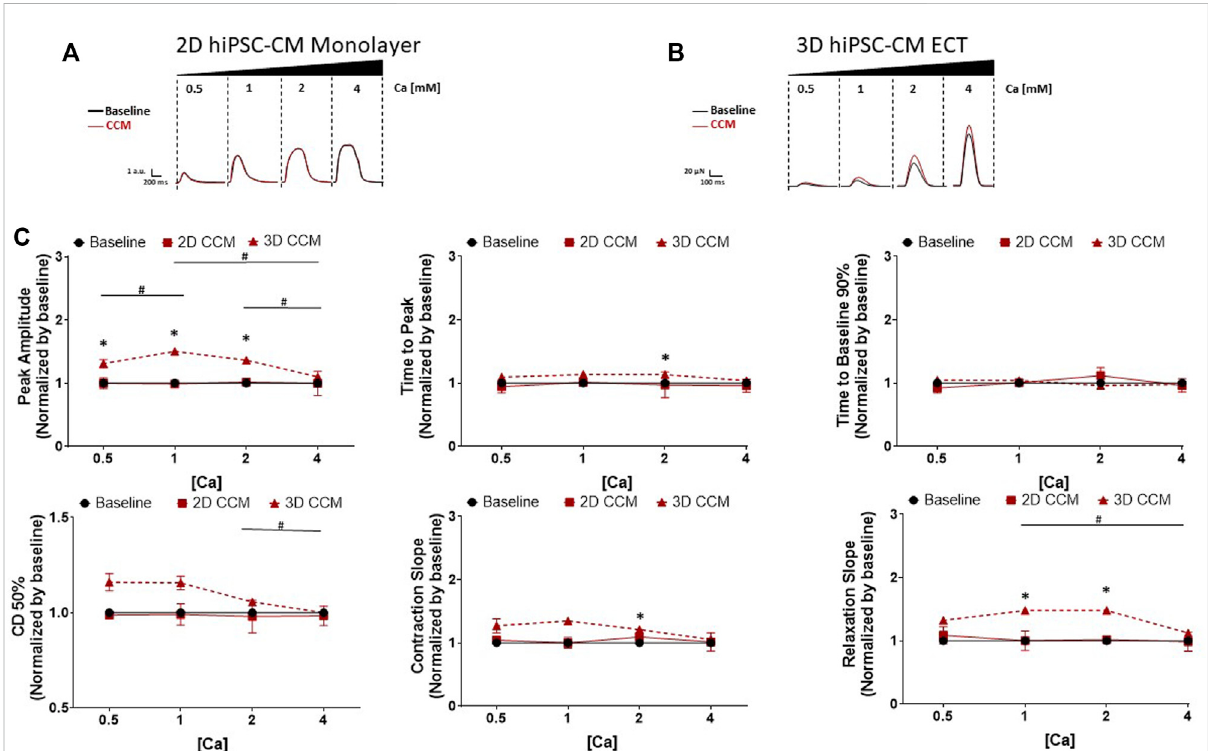
FIGURE 3 Effect of Extracellular Ca Modulation on CCM Response in 2D and 3D models (A) Representative contraction traces for baseline (i.e., fi eld stimulation pacing, 1 Hz). and CCM for 2D hiPSC-CMs monolayer and (B) 3D ECTs. CCM was applied as the standard biphasic CCM waveform (i.e., two biphasic pulse, 7.5 V, 5.14 ms duration, 30 ms delay). hiPSC-CMs were exposed to increasing concentrations of extracellular Ca [Ca o ] 0.5 – 4 mM (C) Summarydatagraphs. Dataaremean±SEM. n =3 – 6pergroup.* p < 0.05(3Dvs.BL), # p < 0.05(3Dvs.3D), + p <